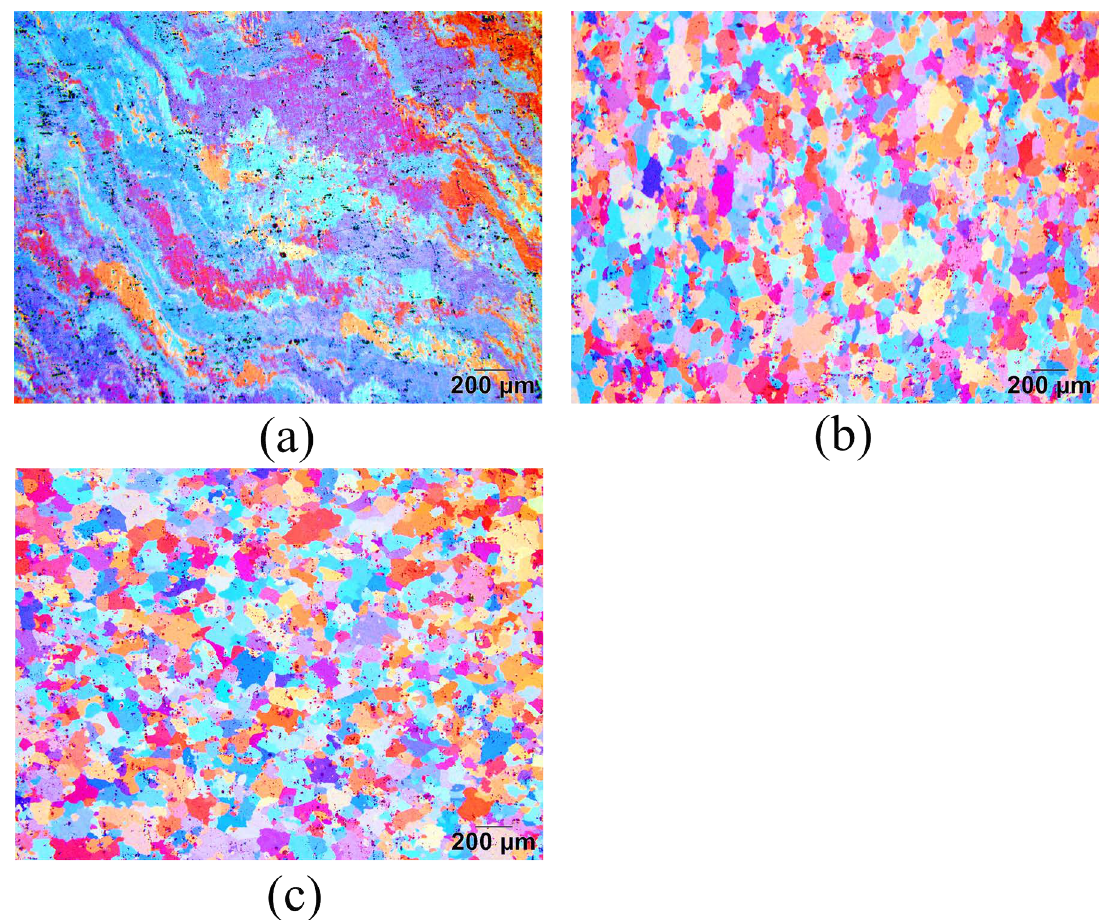
Figure 15. Microstructure of overaged AA 7075 after cold-rolling (75% in thickness reduction) and annealing (400°C) for (a) 8 minutes, (b) 15 minutes and (c) 30 minutes. Obtained by using polarized light